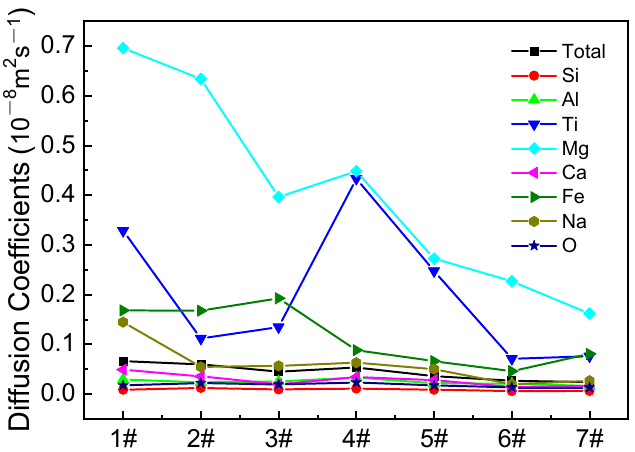
Figure 8. Effect of SiO 2 /Al 2 O 3 ratio on diffusion coefficients.